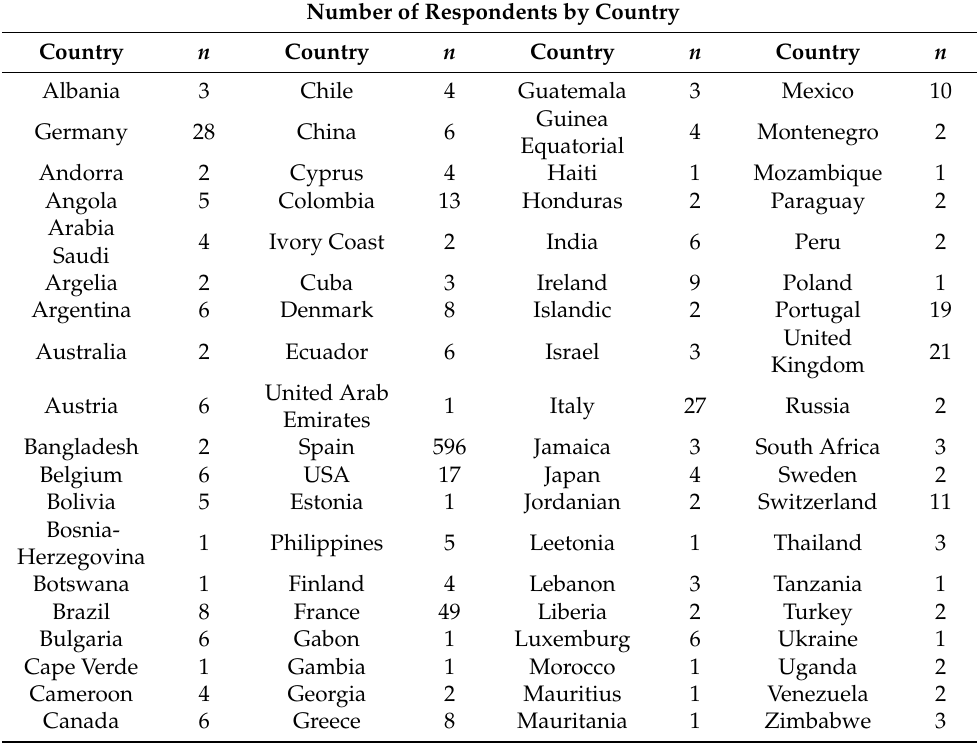
Table 13. Number of respondents per country of the participating